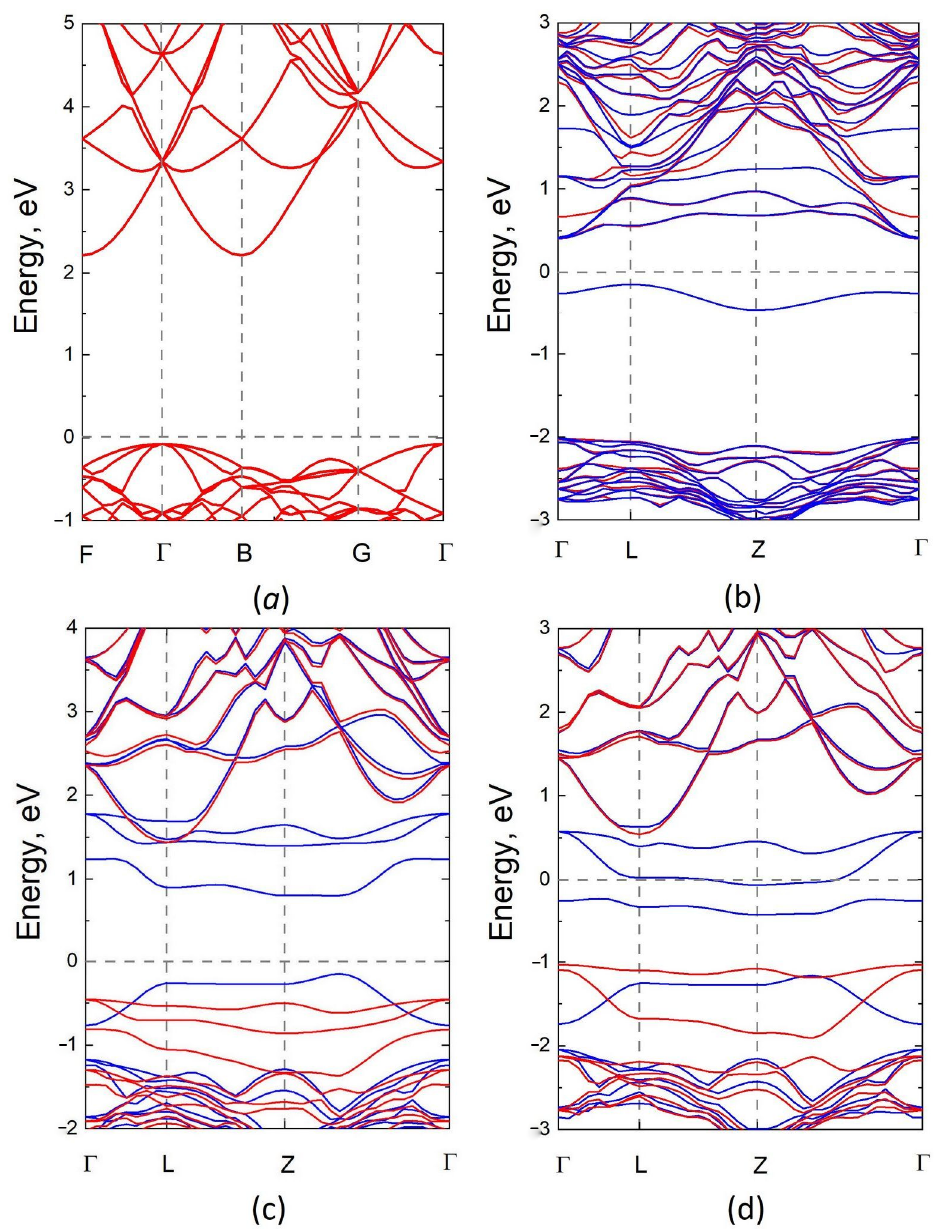
Figure 8. Band structure of an ideal 3C–SiC with the 𝑃1 symmetry and 𝑞 = 0 ( a ) and those of 3C– SiC containing silicon vacancies ( 𝑃3𝑚1 symmetry, 𝑛 (cid:3023) = 3.7 % ) for charges q = + e ( b ), q = − e (cid:3268)(cid:3284) ( c ), and 𝑞 = −2𝑒 ( d ). Cases ( b ) and ( c ) correspond to a magnetic semiconductor, while ( d ) is a mag- netic semimetal. In plots ( b – d ), the bands for electrons with spin “up” and “down” are shown in red and blue, respectively, and there are new blue zones near the Fermi level ( 𝐸 = 0 ). Thus, the magnetic moment of silicon vacancies in SiC leads to the appearance of additional peaks in the imaginary part 𝜀 (cid:2870) of the dielectric function. The real part 𝜀 (cid:2869) of the dielectric function behaves in accordance with the Kramers–Kronig dispersion rela- tion [17]. Figure 9 shows the results of the calculations of the dielectric function for the above-mentioned systems with the 𝑃3𝑚1 symmetry group and different concentrations of silicon vacancies at different 𝑞 from +1𝑒 to −2𝑒 .